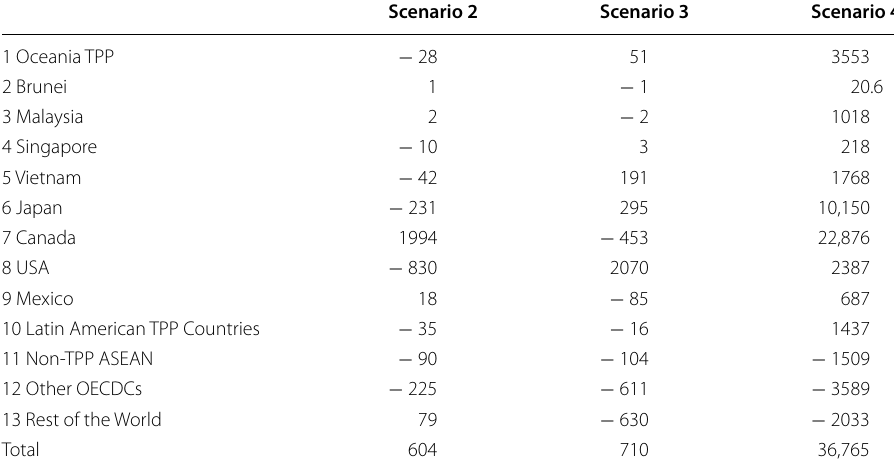
Table 10 Total welfare impact of the other TPP members and Rest of the World in million USD (with USA)